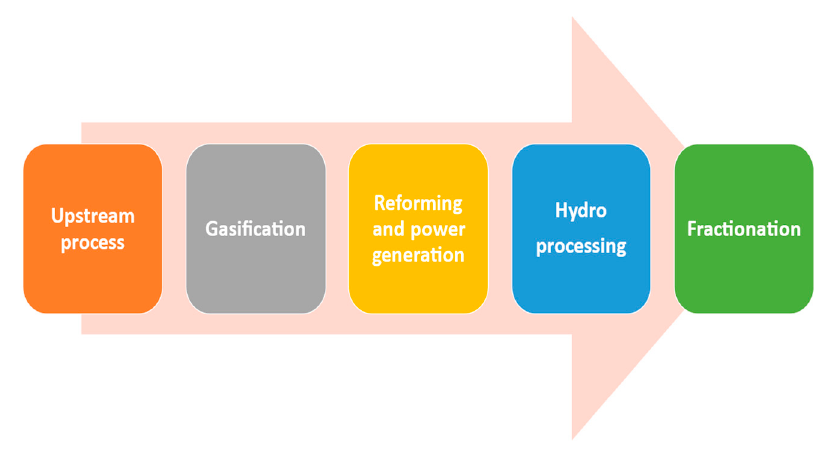
Figure 5. Flowsheet of an integrated system.